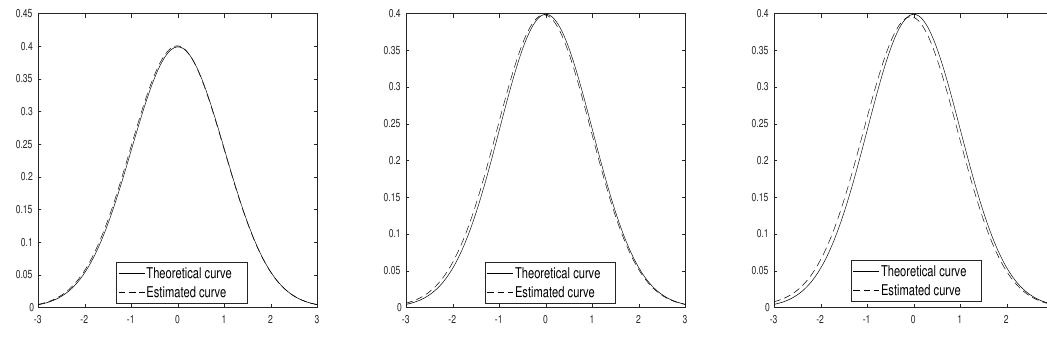
Figure 2: n = 200 and CR ≈ 55% for ρ 1 = 0.3, 0.6 and 0.9 respectively.